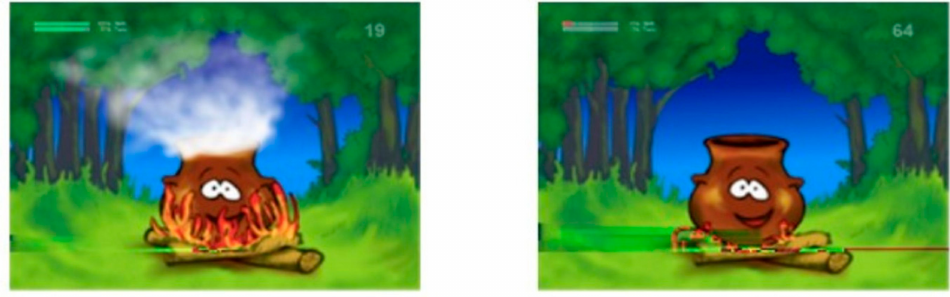
Figure 1. “Clay Pot” simulation board. Source: DigiTrack ® EEG System